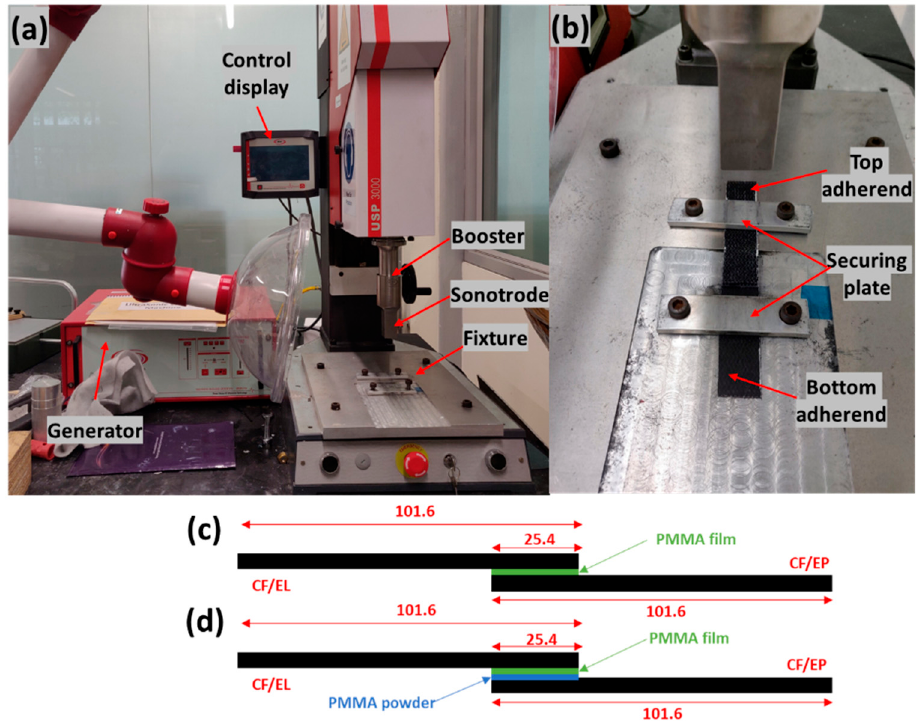
Figure 4. ( a ) Ultrasonic welding machine. ( b ) Close-up of the fixture welding configuration: ( c ) EL-EP, CF/EL composite with CF/EP composite, ( d ) EL-EP_PMMA, CF/EL composite with CF/EP composite with PMMA powder as a coupling layer.